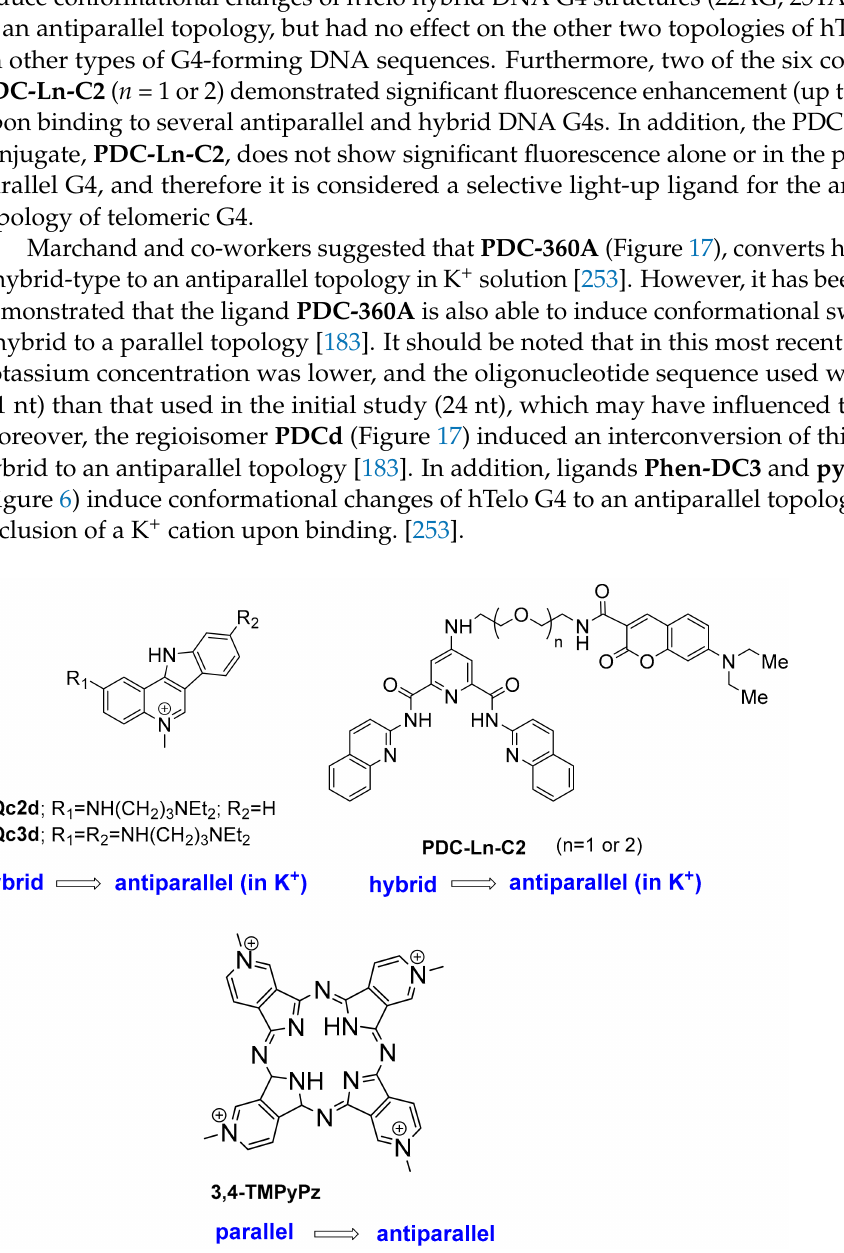
Figure 22. G4 ligands able to induce a topological switch to